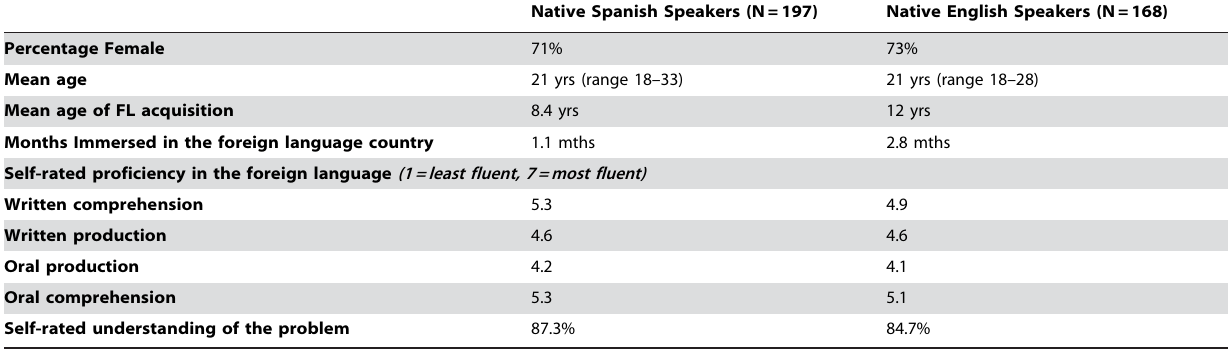
Table 3. Experiment 2 9 s participants’ details.